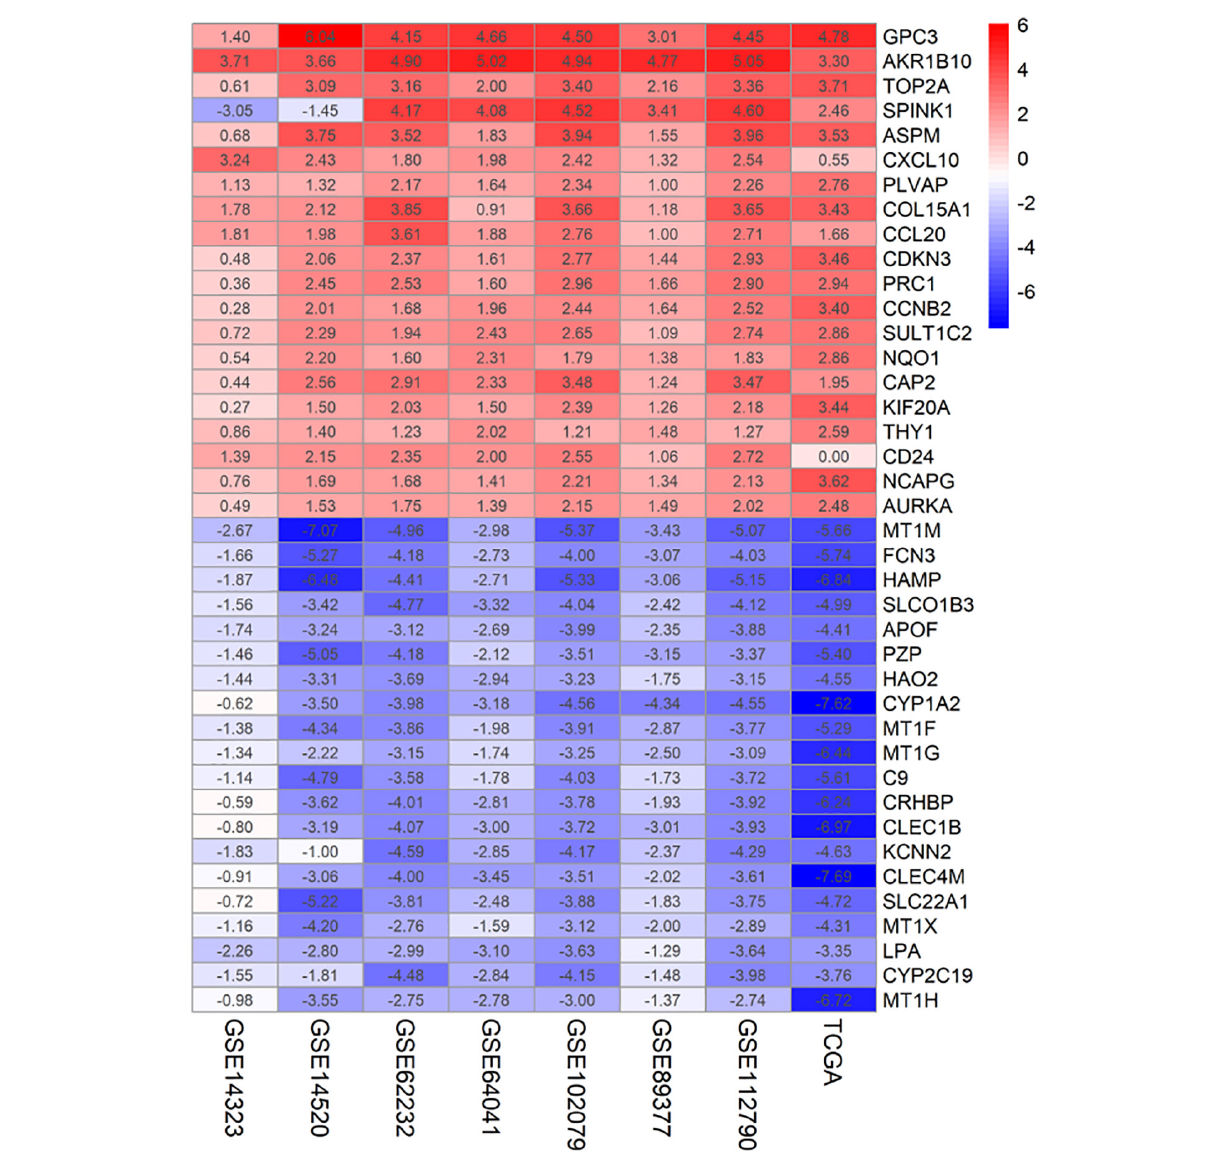
FIGURE 1 | Identification of DEGs of 7 GEO datasets and TCGA dataset using RRA. The heatmap of the top 20 up- and down-regulated DEGs in the integrated GEO datasets analysis. The rows represent the genes and the columns represent the GEO dataset. The number in the rectangle represents the log 2 FoldChange value. Red represents up-regulated genes, blue represents down-regulated